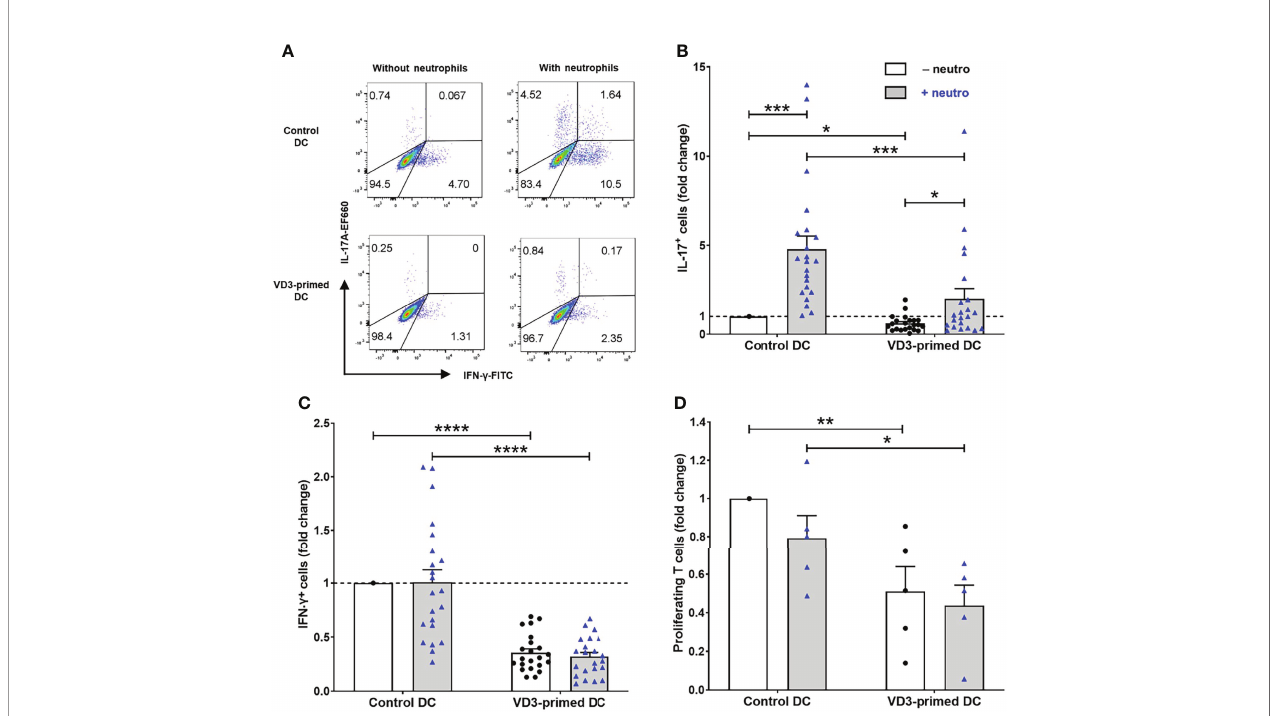
FIGURE 1 | Priming of dendritic cells (DCs) with vitamin D3 (VD3) impedes neutrophil-dependent Th17 cell development. (A) IL-17A and IFN- g expression is shown in restimulated T cells cultured with autologous control or VD3-primed DCs, in the presence or absence of neutrophils. Representative fl ow cytometry plots are shown. (B, C) The percentage of IL-17 + cells and IFN- g + cells normalized to control DCs without neutrophils from 22 independent experiments (mean ± SEM) is depicted. Friedman tests with Dunn ’ s post hoc test were performed. (D) T-cell proliferation measured on day 5 normalized to control DCs without neutrophils (mean ± SEM); n = 5 independent experiments. One-way ANOVA with Holm – Sidak ’ s post hoc test was performed. * p < 0.05, ** p < 0.01, *** p < 0.001, **** p <